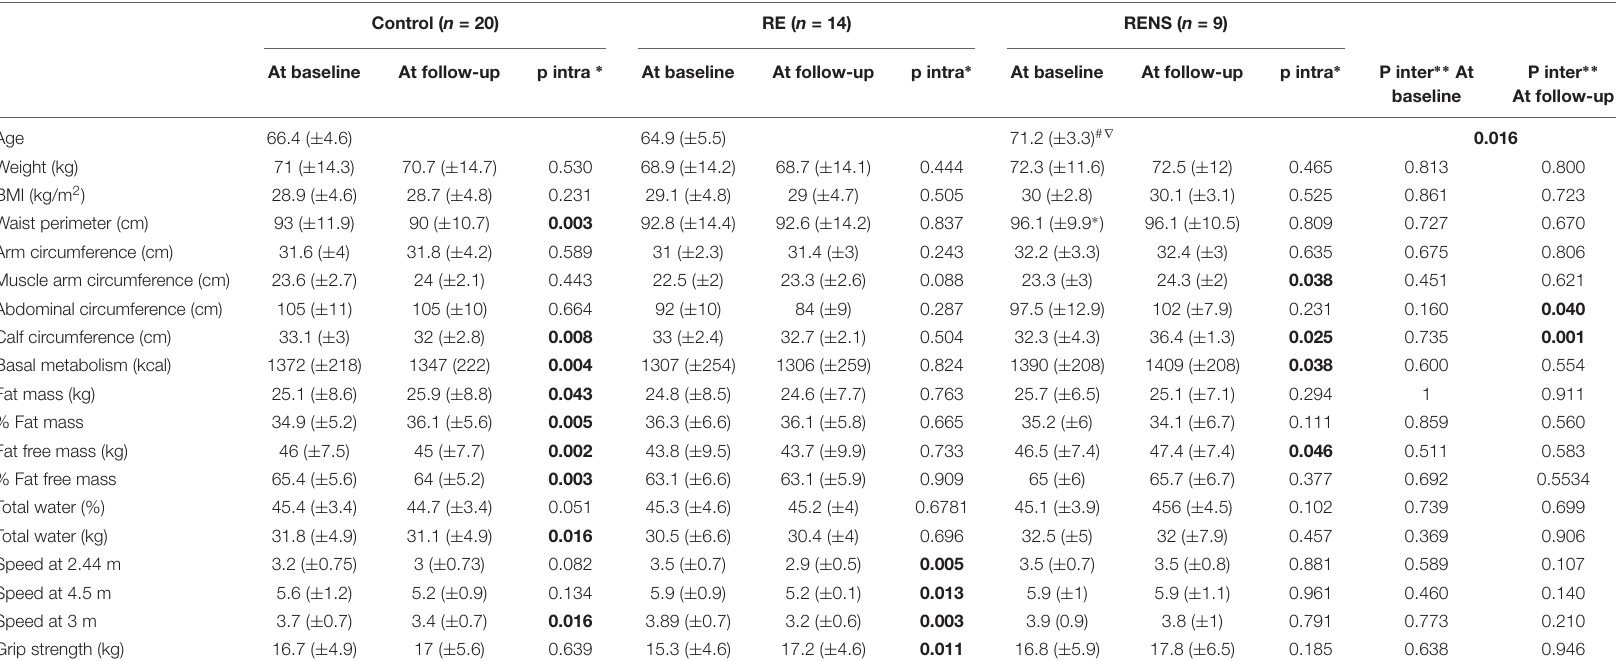
TABLE 1 | Evolution of body composition, anthropometric parameters walking speed and